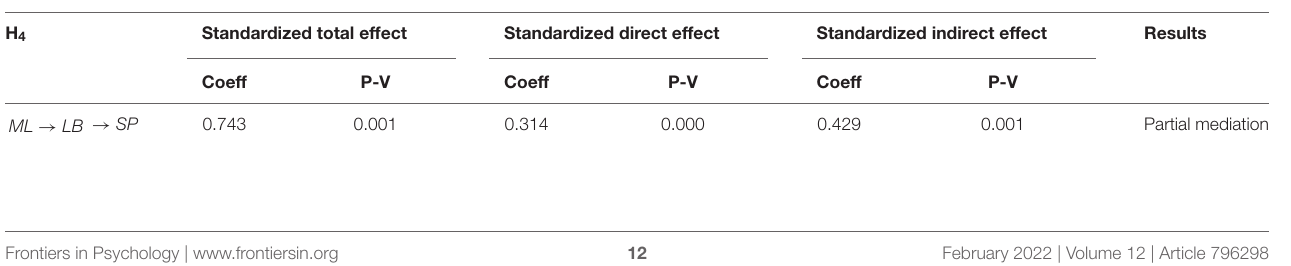
TABLE 9 | Standardized direct, indirect, and total